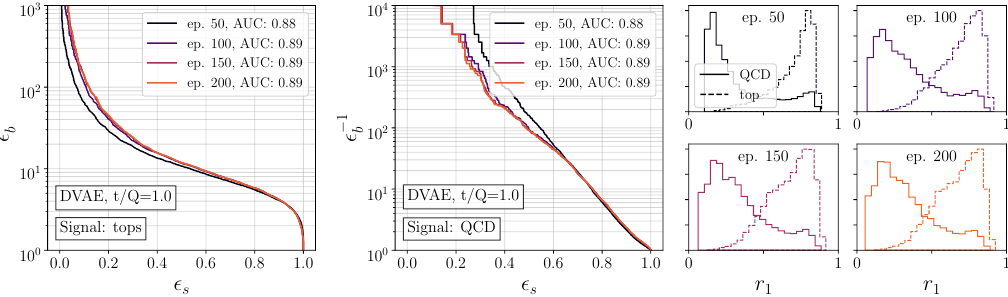
Figure 7: Results for the DVAE. In the large panels we show the ROC curves for tagging top and QCD as signal. In the small panels we show the distributions of the top and QCD jets in the latent space developed over the